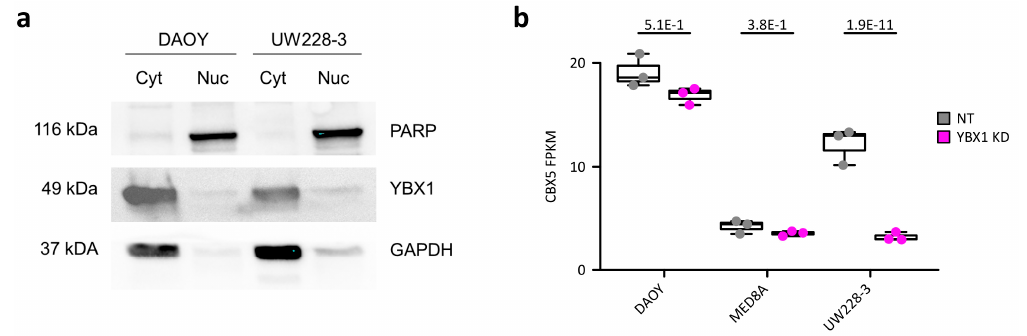
Figure A3. ( a ) Localization western blot in fractionated cellular protein extract for cytoplasmic fraction (Cyt) and nuclear fraction (Nuc) for nuclear localized protein PARP, cytoplasmic localized protein GAPDH and YBX1 protein in DAOY and UW228-3 cell lines. ( b ) CBX5 expression as normalized FPKM taken from RNA-Seq data. Differential expression analysis was performed with edgeR, and FDR values between NT and YBX1 KD are reported.